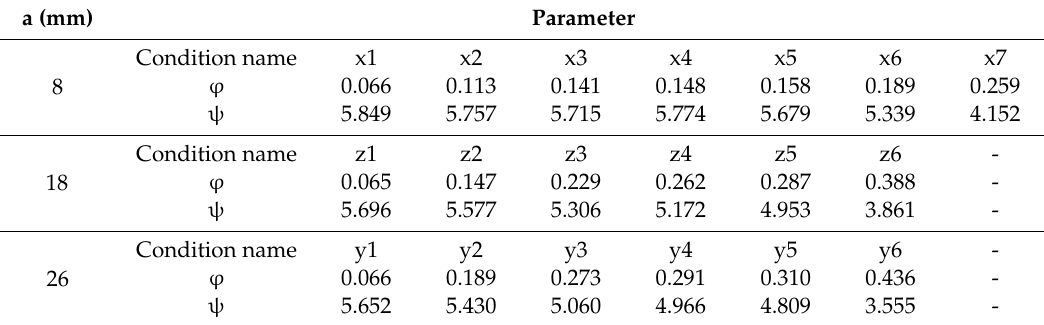
Table 2. Parameters of the PIV measurement working